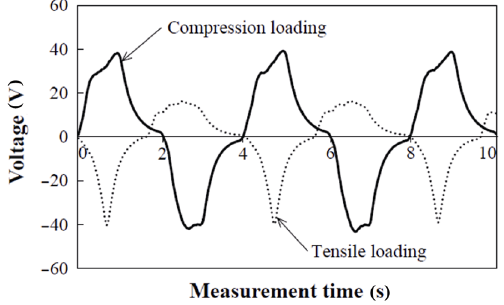
Fig. 10 Voltage generated from PZT ceramic under tensile and compressive stress as a function of measurement